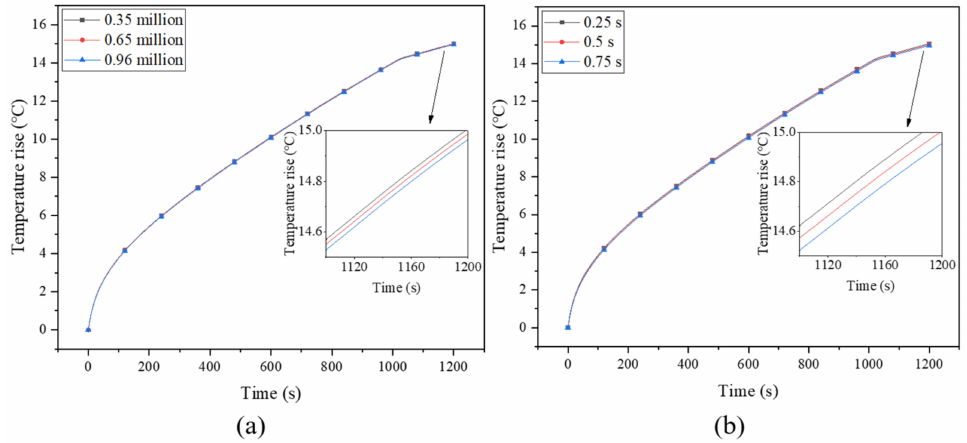
Figure 2. ( a ) Grid independence test and ( b ) optimal time